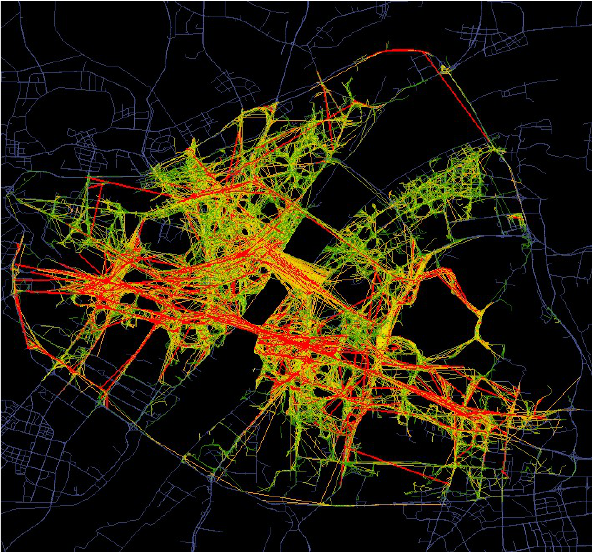
Figure 4. Slow trajectories overview on May 1st